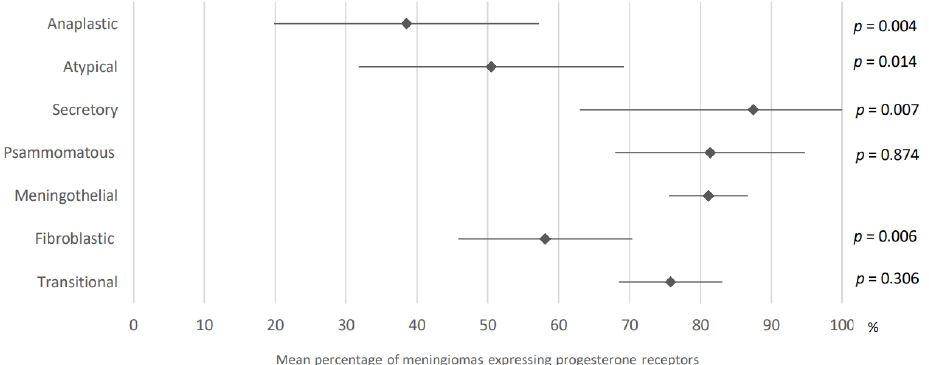
Figure 10. Comparison of progesterone receptors expression in meningiomas according to histolog- ical subtype. The results are expressed as a mean associated with their 95% confidence interval. p : meningothelial versus another histological subtype. Number of analyzed articles related to the